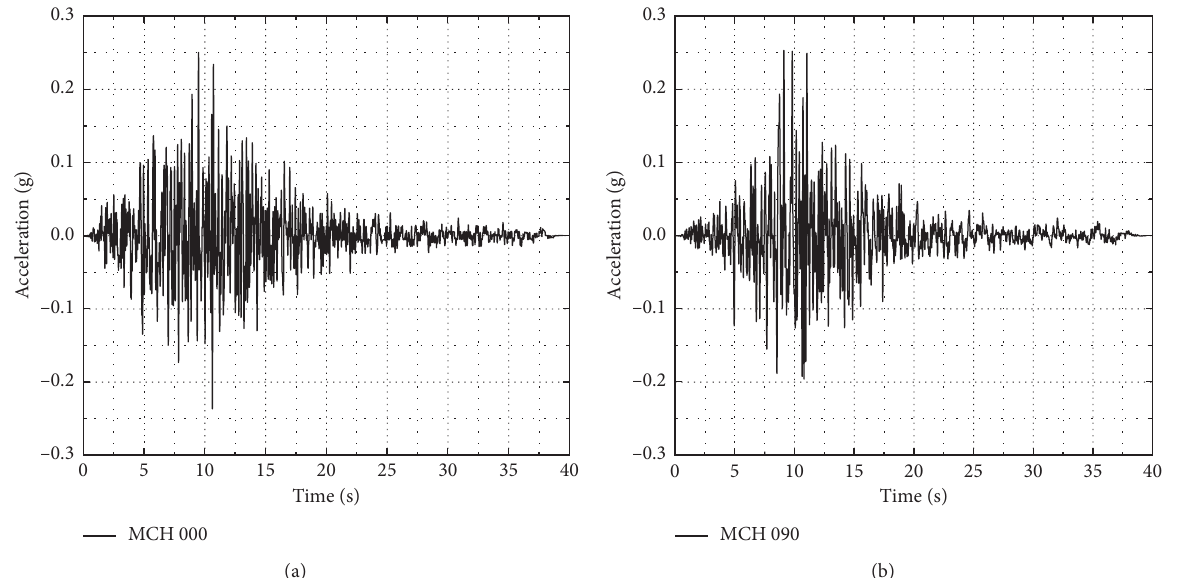
Figure 6: Input motions at the base. (a) MCH-000 and (b) MCH-090.